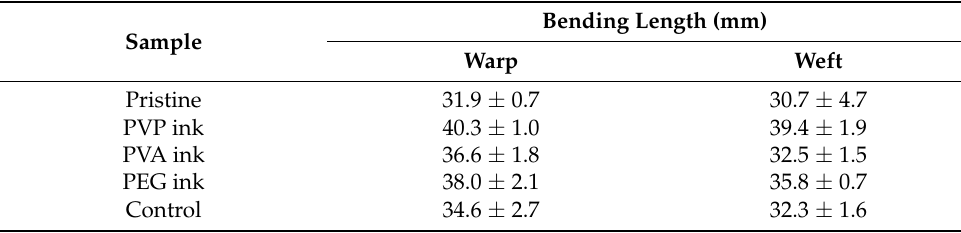
Table 7. Bending length of the pristine and printed fabrics.